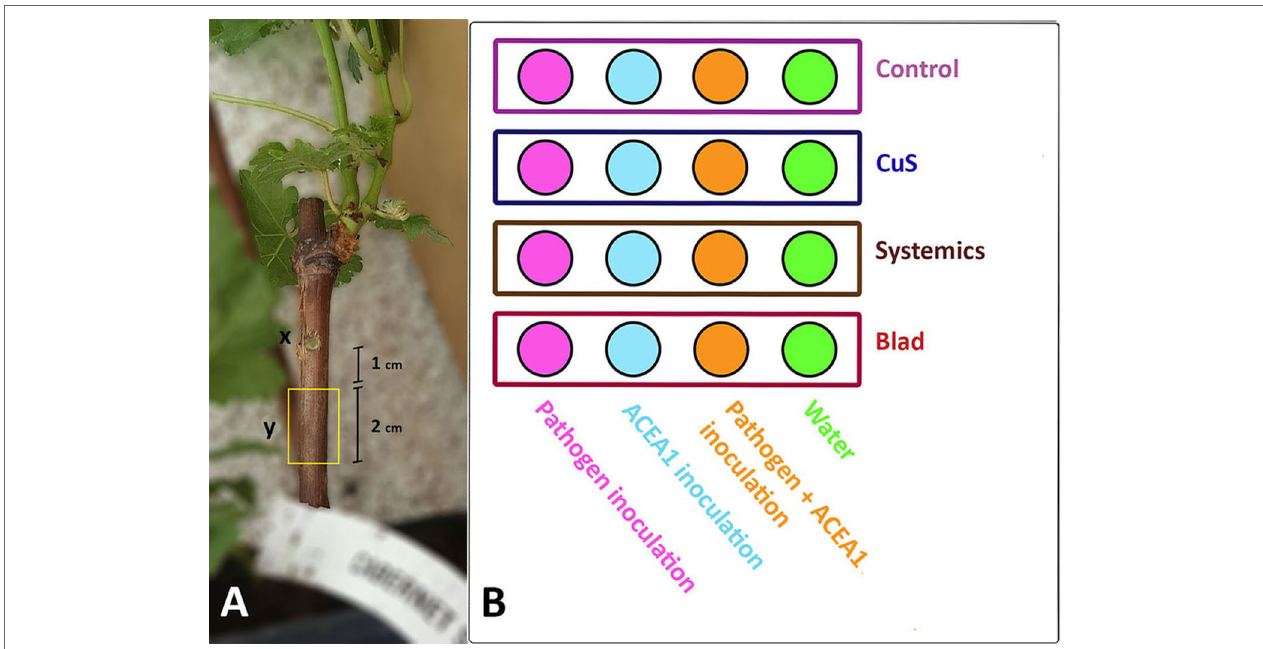
FIGURE 1 | (A) Grapevine rooted cutting of cv. Cabernet Sauvignon. ( x ) Inoculation point of a conidia suspension of Phaeomoniella chlamydospora , ACEA1, P. chlamydospora and ACEA1, or sterile distilled water. ( y ) Two centimeters of wood, located 1 cm below the inoculation point, was sampled 3 months post- inoculation, and the wood’s mycobiome was examined through metabarcoding ( n = 5 for each combination inoculum/treatment). (B) Experimental setup. Each circle represents a set of eight plants that underwent the same treatment. Same colors in the circles represent the same inoculum type, while rectangles represent different treatments. All possible combinations of inoculum and fungicide application by foliar spray are shown.